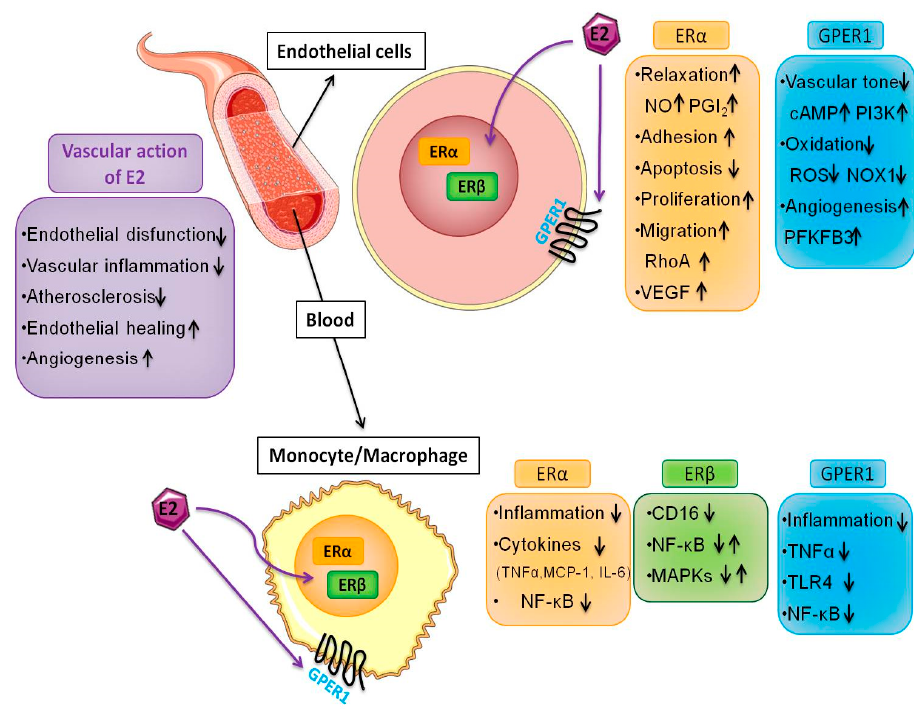
Figure 1. Multiple effects of 17 β -estradiol (E2) in endothelial cells and macrophages. E2 induces protective effects on the cardiovascular system by promoting endothelial healing and angiogenesis